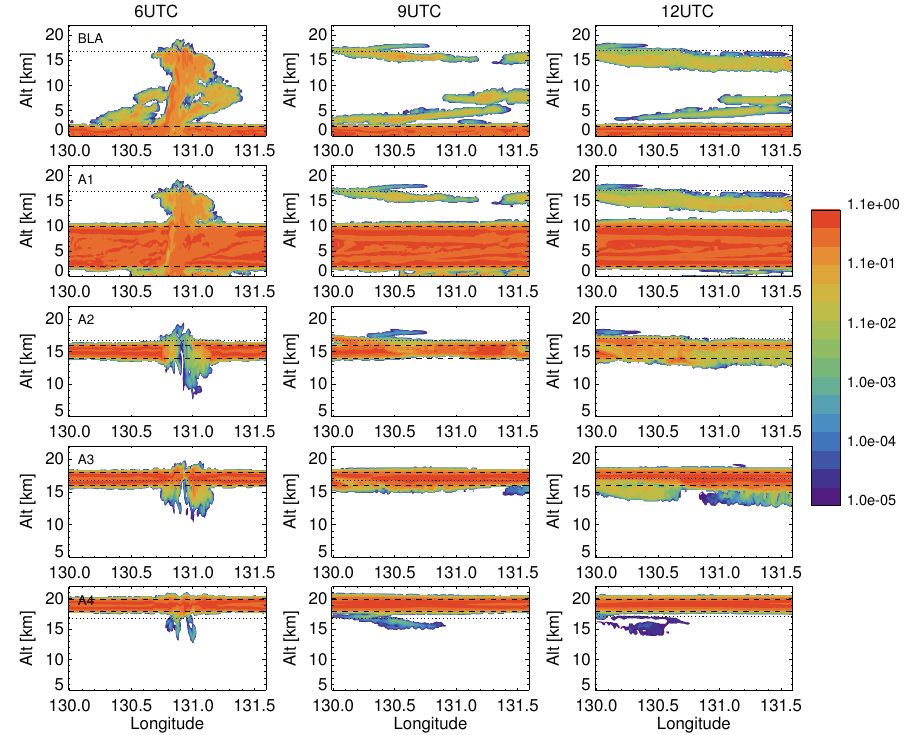
Figure 6. Cross sections of the passive altitude layer tracers at 06:00UTC (left panels) and 12:00UTC (right panels). Shown are, from top to bottom, BLA (initialised below 2km), A1, A2, A3, and A4. The initialisation layers of the passive tracers are indicated by the dashed lines. The simulated cold point tropopause is shown by the dotted line. Note the changing y axis scale.